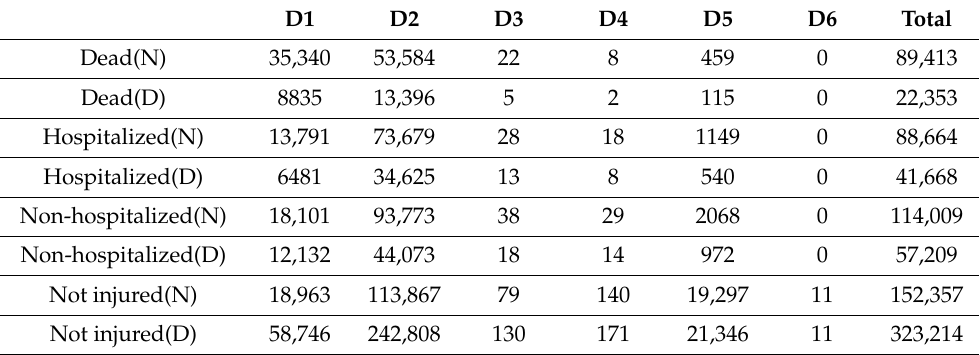
Table 13. Number of casualties in the 1721 earthquake in District 4 of